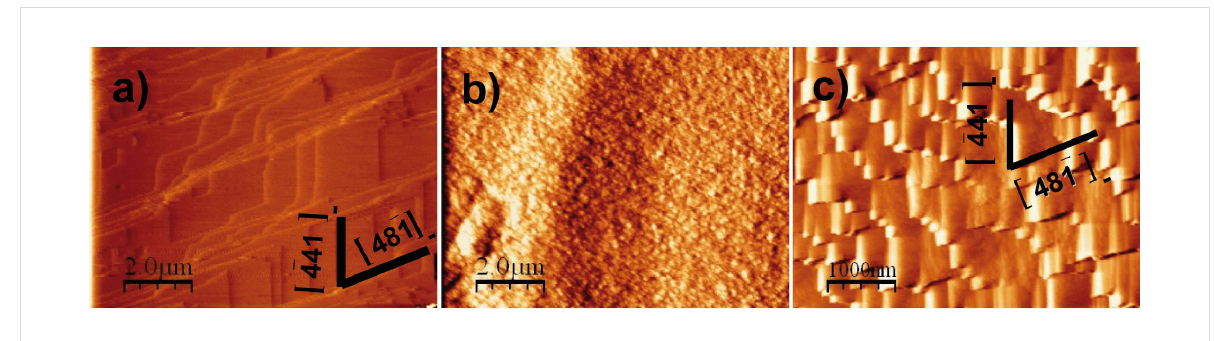
Figure 6: AFM deflection images of reacting (104) calcite surface: a) dissolution in Millipore MQ water; b) after injecting a solution in equilibrium with gypsum at pH 2.18, gypsum precipitation starts (1.5 min) and c) gypsum arrows grow laterally and coalesce (41 min).